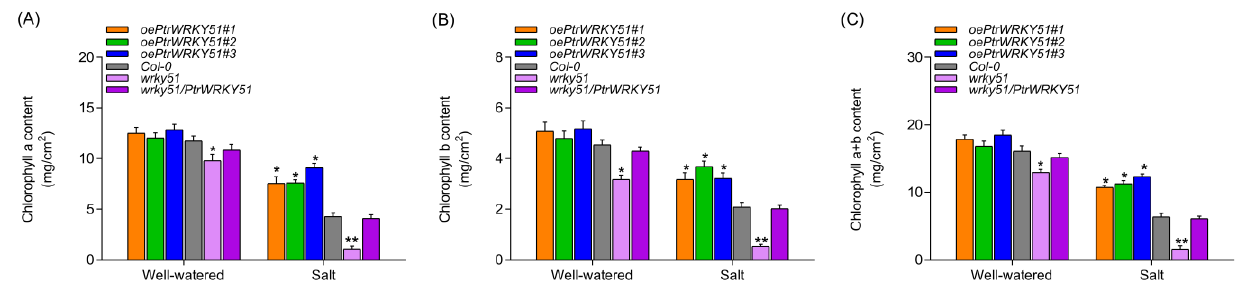
Figure 7. The chlorophyll content analysis of over-expressing PtWRKY51 plants under salt treatment conditions. Determine of the content of chlorophyll a ( A ), chlorophyll b ( B ) and chlorophyll a + b ( C ) among oe PtWRKY51 , Col-0, wrky51 , and wrky51 / PtWRKY51 plants under salt stress conditions. The data are represented as means ± SE ( n = 12). The asterisks (* and **) represent significant differences (* p < 0.05 and ** p < 0.01) compared to the control.